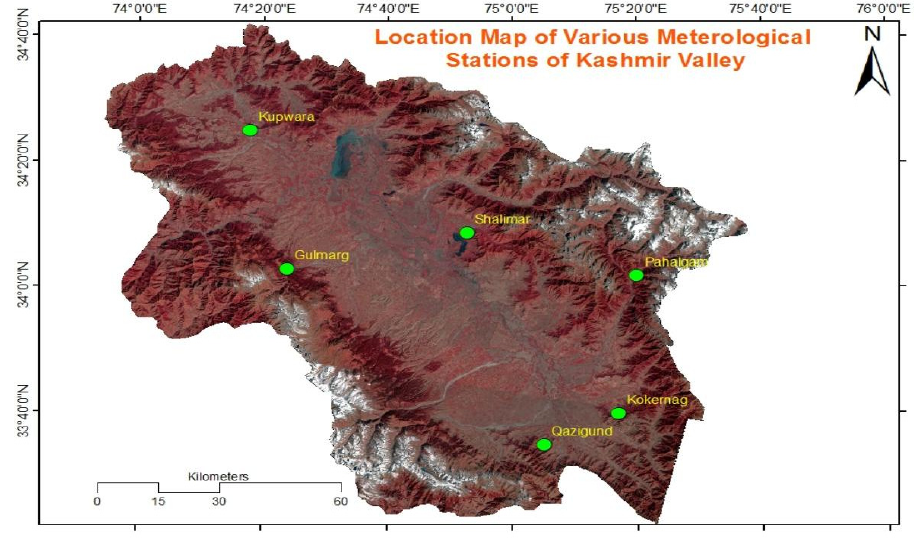
Figure 1. Location map of various meteorological stations of Kashmir